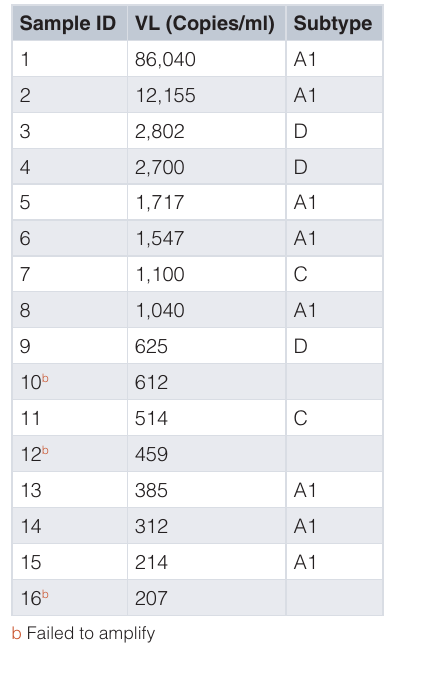
Table 5. Viral load levels and HIV-1 subtypes detected in plasma samples used for amplification sensitivity testing.